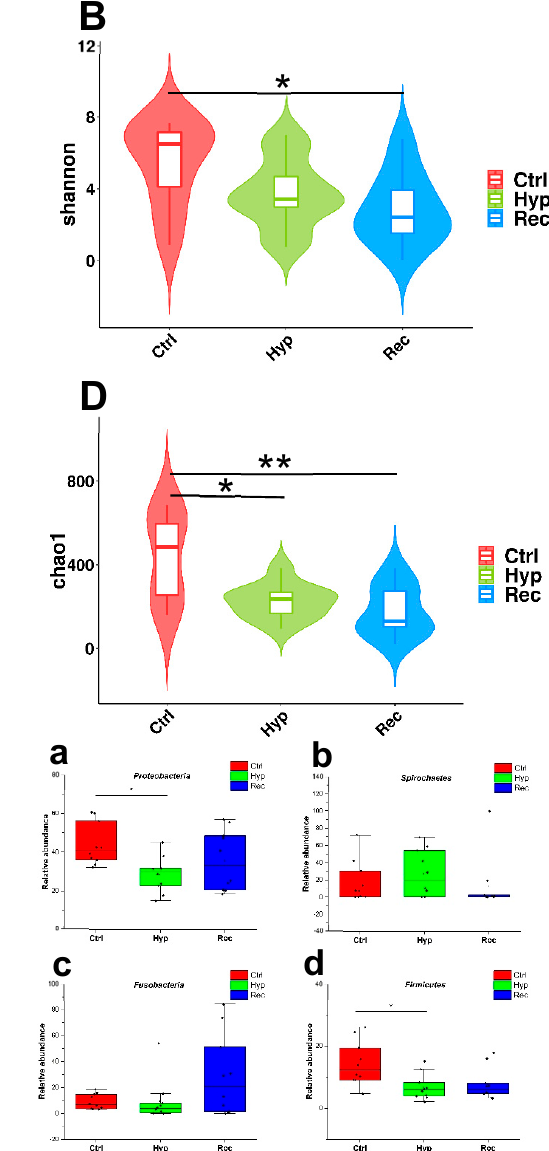
Figure 8. Intestinal alpha diversity of largemouth bass under hypoxic stress. ( A ): Observed operational taxonomic units (OTUs) index (alpha) ( n = 10). ( B ): Shannon’s index (alpha) ( n = 10), ( C ): Simpson’s index (alpha) ( n = 10). ( D ): Chao1 index (alpha), * and ** indicate significant differences in abundance among different groups (Kruskal–Wallis test, *: p < 0.05, **: p < 0.01) ( n = 10). ( E ): Relative abundance of main taxa of intestinal microflora in Ctrl group, Hyp group, and Rec group ( a–d ) ( n = 10). Each bar represents relative abundance in each sample, and shows 27 most abundant taxa.